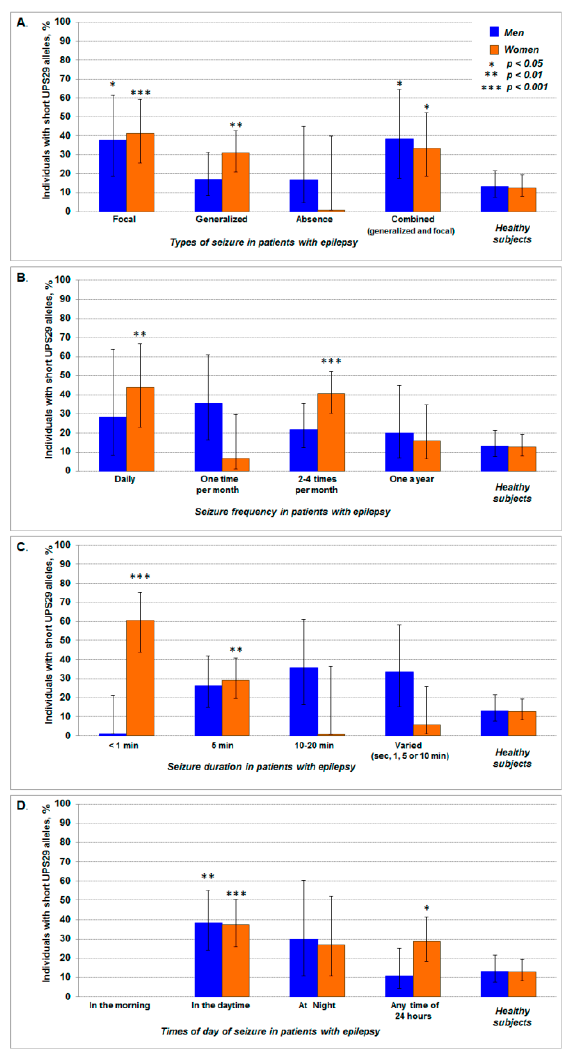
Figure 3. The frequency of carriers of short UPS29 alleles among patients with different clinical patterns of seizures: type ( A ), frequency ( B ), duration ( C ), and time of day of seizure onset ( D ). The data is shown with 95% CI. The asterisk indicates statistically significant differences in comparison with control (healthy subjects).